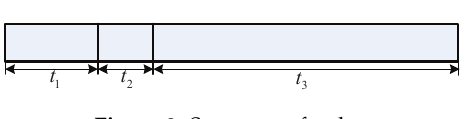
Figure 2. Structure of a